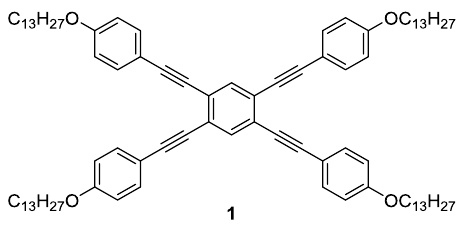
Figure 1. The alkoxy substituted cruciform-shaped tetrakis(phenylethynyl)benzene ( 1 ) reported by Goodby et al .